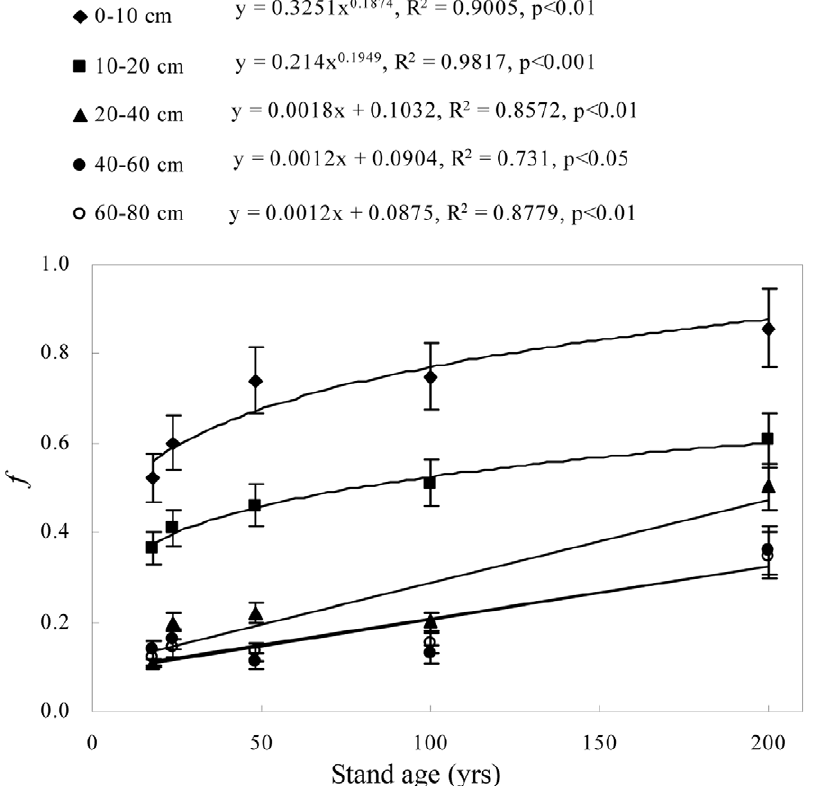
Figure 5. Change in the proportion ( f ) of forest-derived organic carbon to total organic carbon with different stand ages, by soil depth (the error bars are standard deviation of the means).